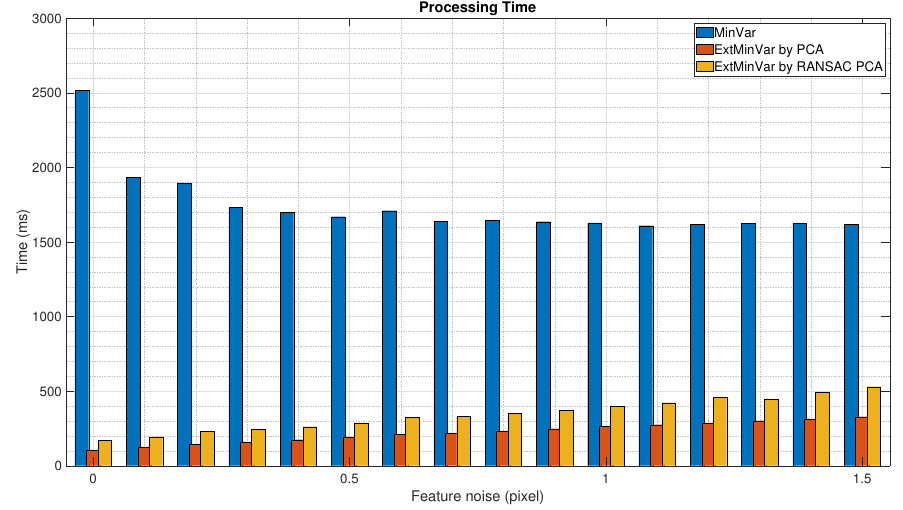
Figure 12. Experimental results using synthetic data with feature noise [0–1.5 pixel]: Processing time during calibration).